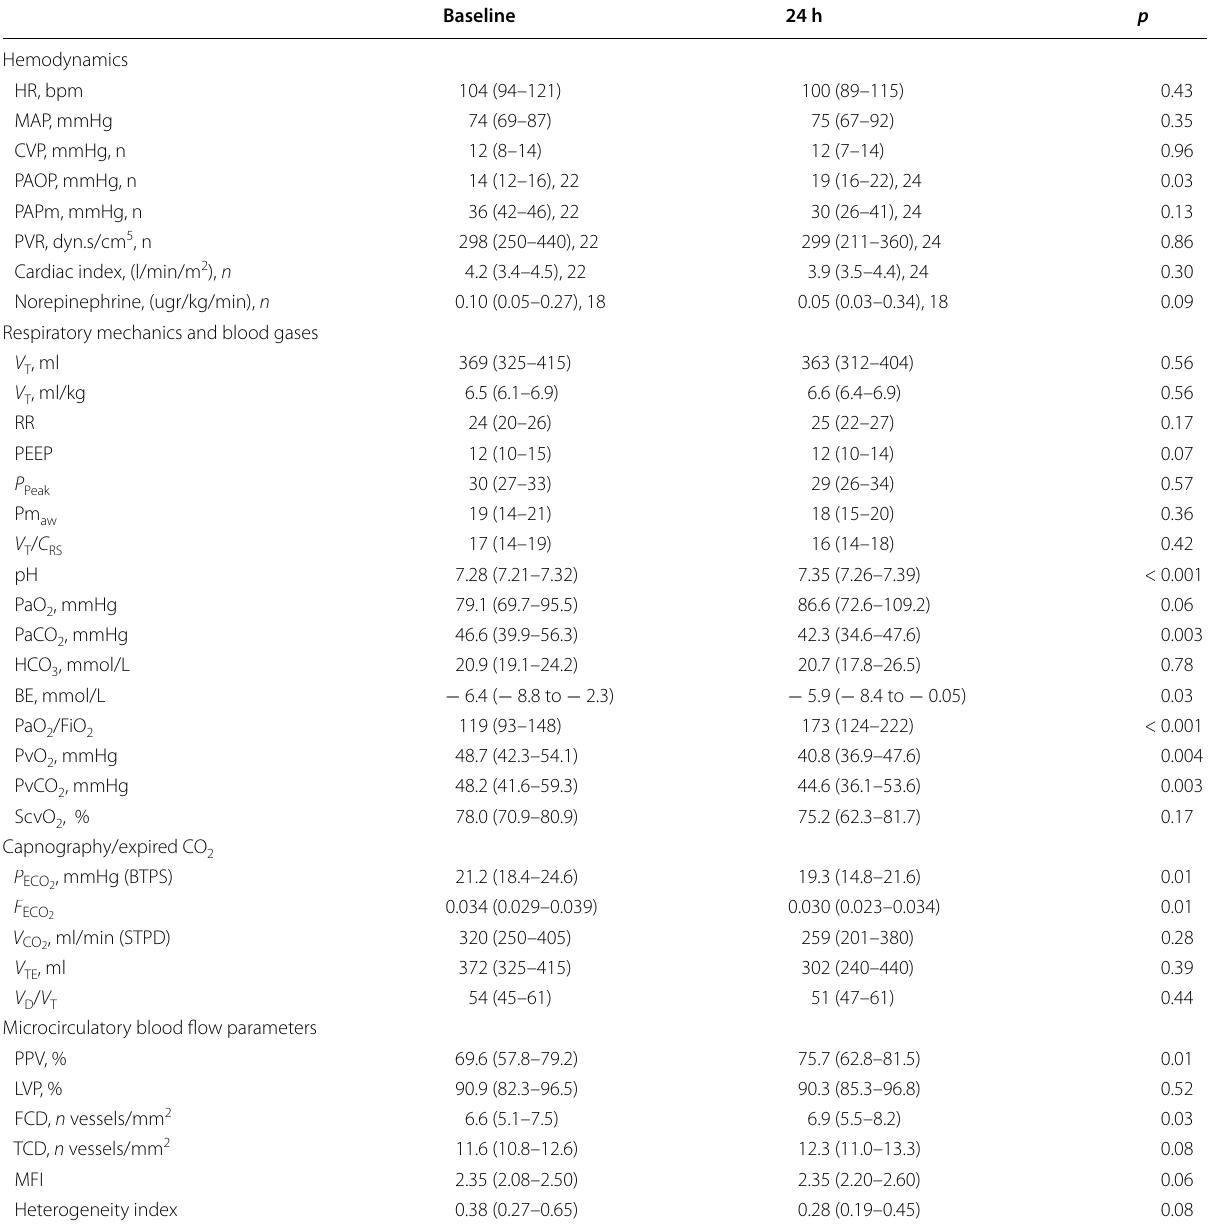
Table 2 Hemodynamics, respiratory mechanics, blood gases analysis, V CO 2 , V at baseline and 24 h